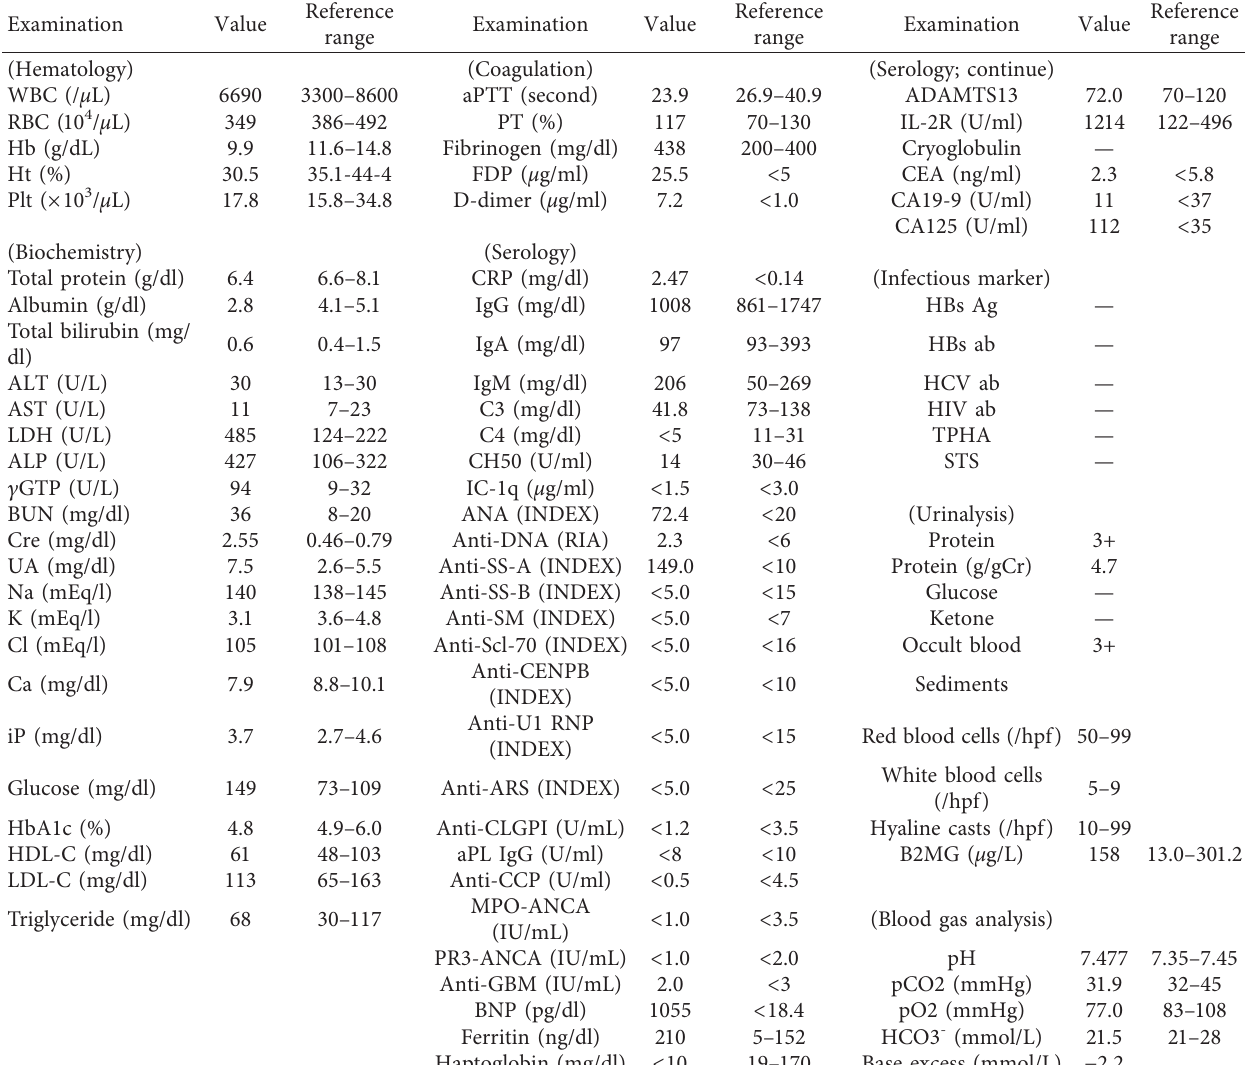
Table 1: Laboratory data upon the first admission of the